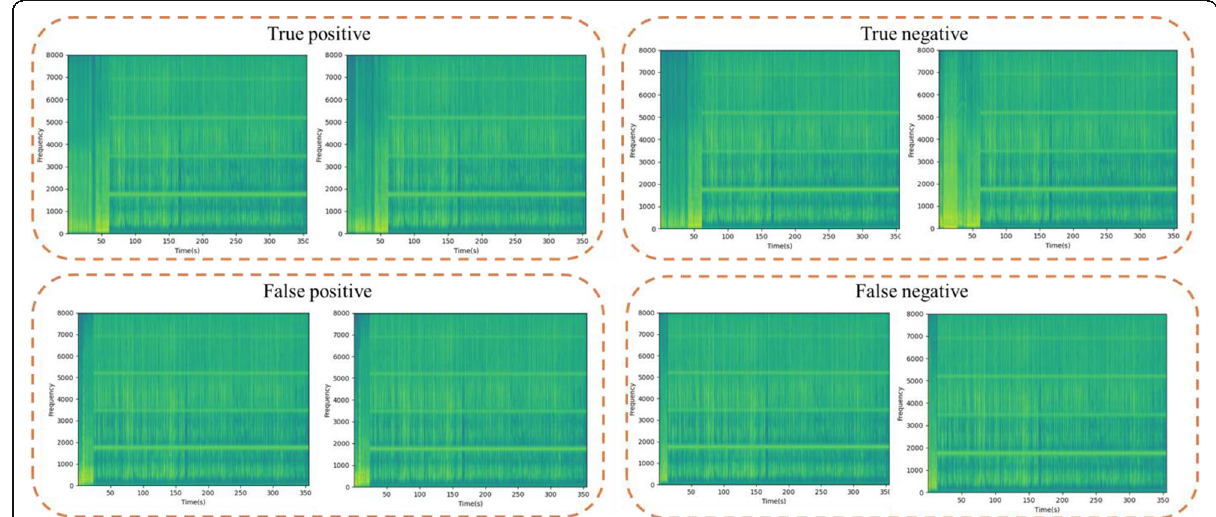
Fig. 8 The visualization results of anchor voiceprint